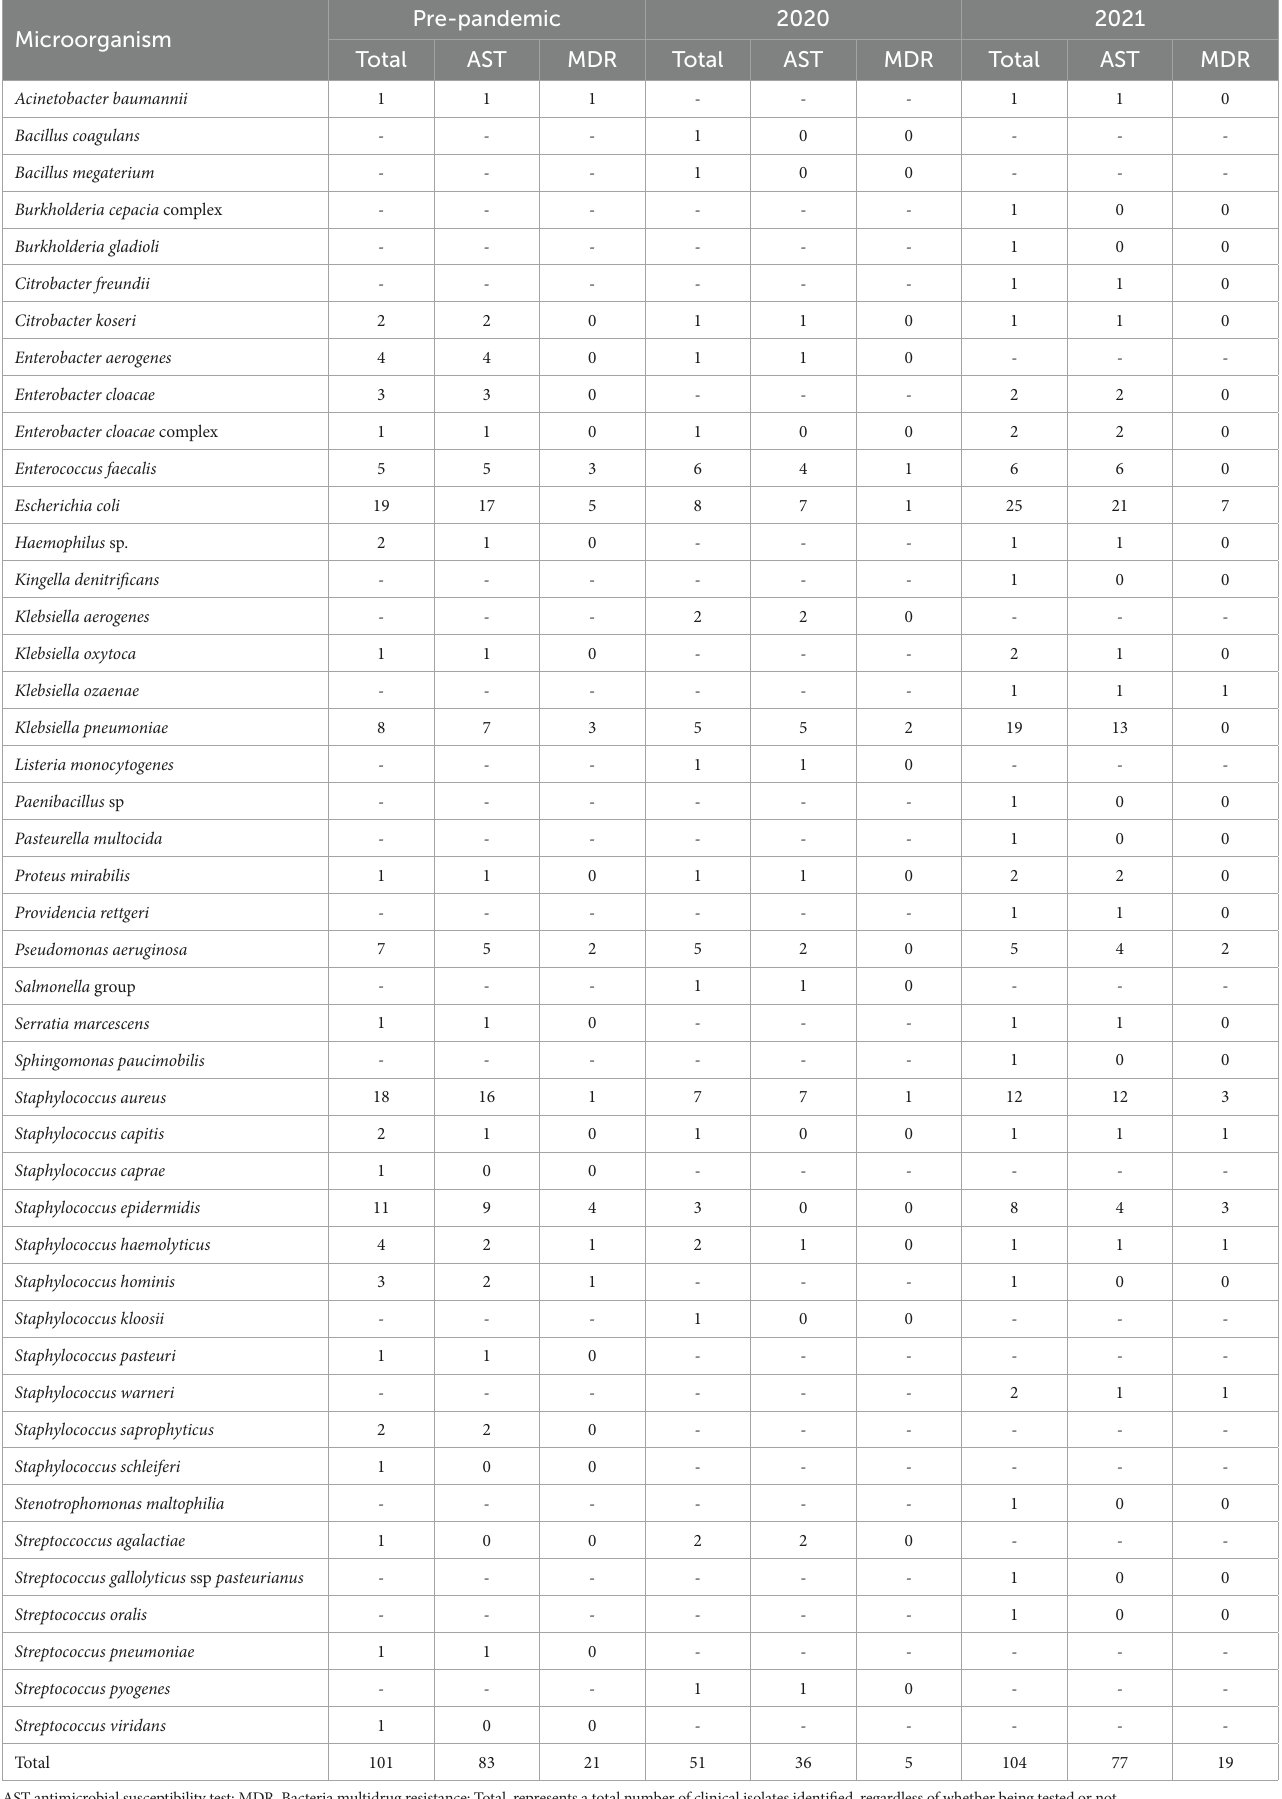
TABLE 1 Clinical isolates identified at Antonio Pedro University Hospital during the study period.